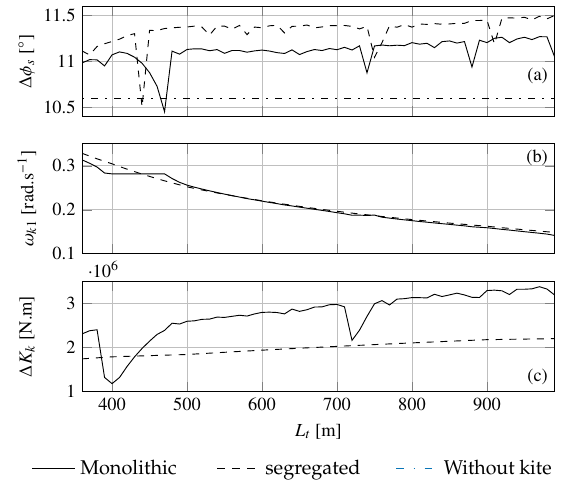
Figure 16. ( a ) Amplitude of the ship roll motion, ( b ) first kite harmonic frequency and ( c ) amplitude of the kite moment of excitation for different tether lengths from 360 m to 990 m by step length of 10 m with a beam regular wave of 2.5 m high at a frequency of ω w = 0.8 rad.s − 1 .